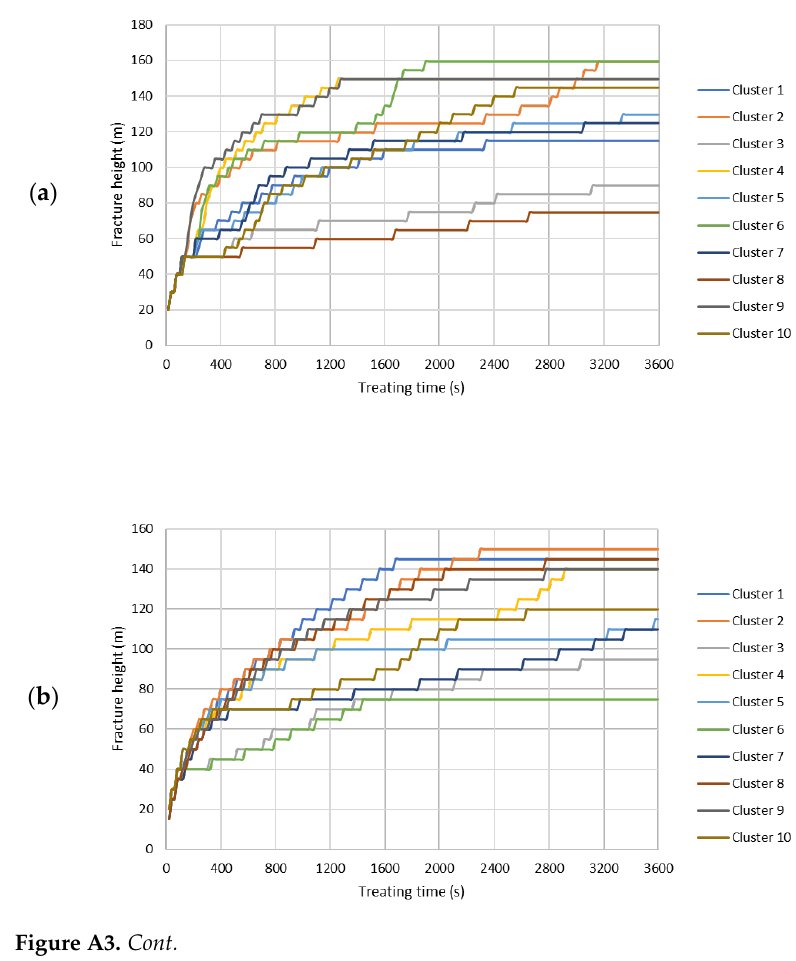
Figure A3. Fracture height of each cluster during the hydraulic fracturing treatment. ( a ) Slick water case. ( b ) NG foam case. ( c ) Hybrid NG/NG foam case.